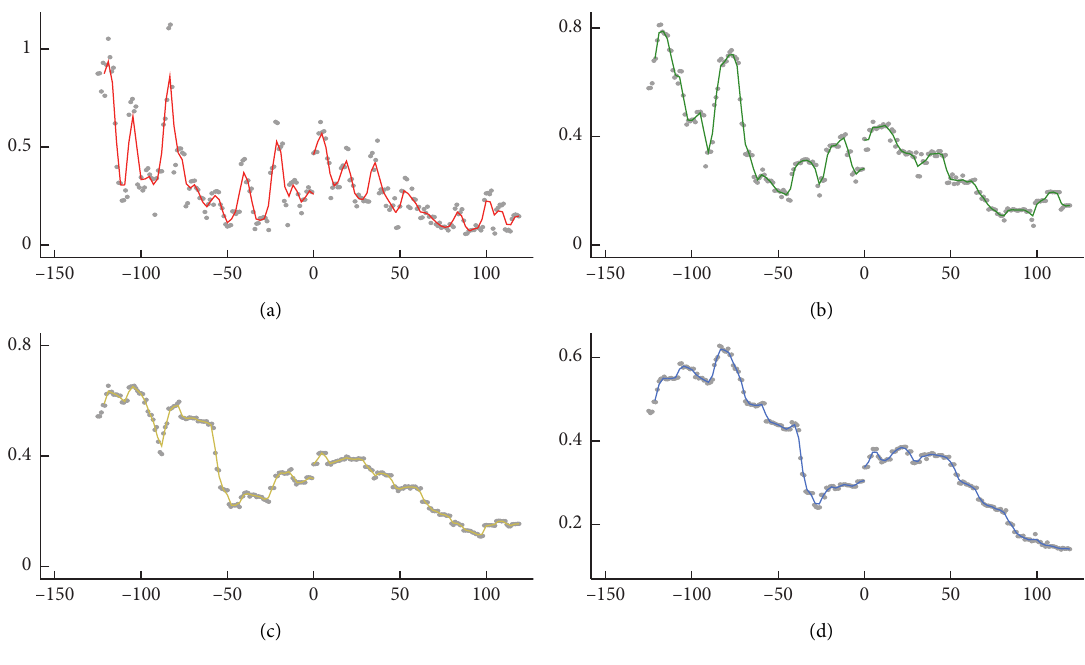
Figure 5: The RDD results of the finance industry. (a) hv5, (b) hv15, (c) hv30, and (d) hv50.